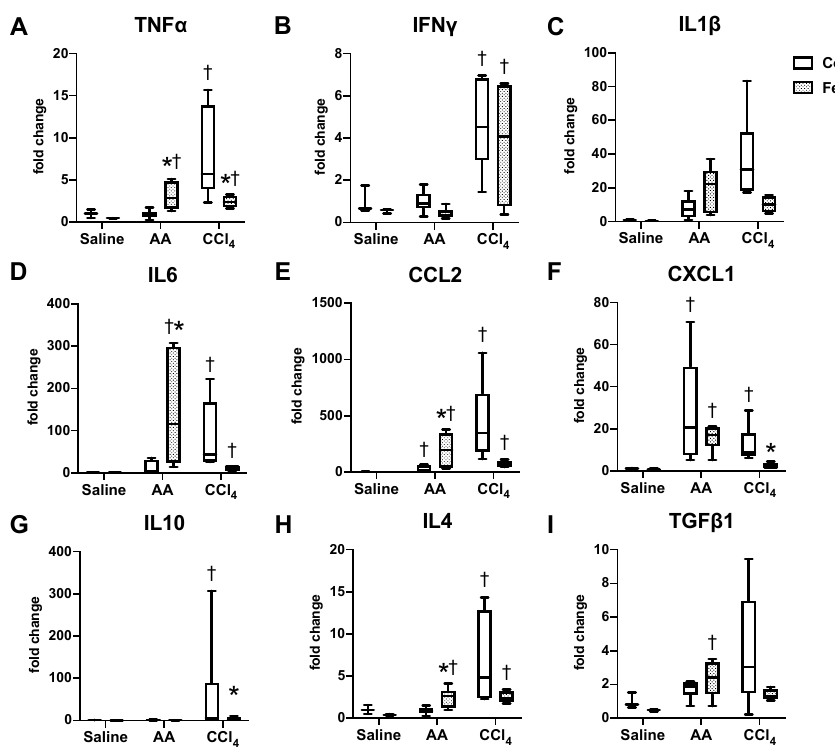
Figure 5. Hepatic expression of TNF α ( A ), IFN γ ( B ), IL1 β ( C ), IL6 ( D ), CCL2 ( E ), CXCL1 ( F ), IL10 ( G ), IL4 ( H ), TGF β 1 ( I ). Data were normalized by the expression of 18S rRNA and are expressed as fold change to Cont-saline group. * p < 0.05 vs. control diet group with same chemical administration (diet factor), † p < 0.05 vs. saline group with same diet feeding (chemical factor), by Sidak’s multiple comparison.